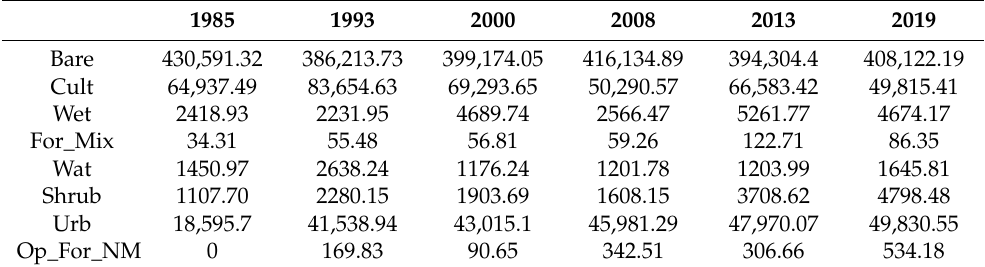
Figure 9. Change map between the time interval (the dark and light color indicate not-changed and changed areas, respectively.): ( a ) 1985–1993; ( b ) 1993–2000; ( c ) 2000–2008; ( d ) 2008–2013; ( e ) 2013–2019. Table 7. LULC change (ha) from 1985 to 2019 based on classified Landsat